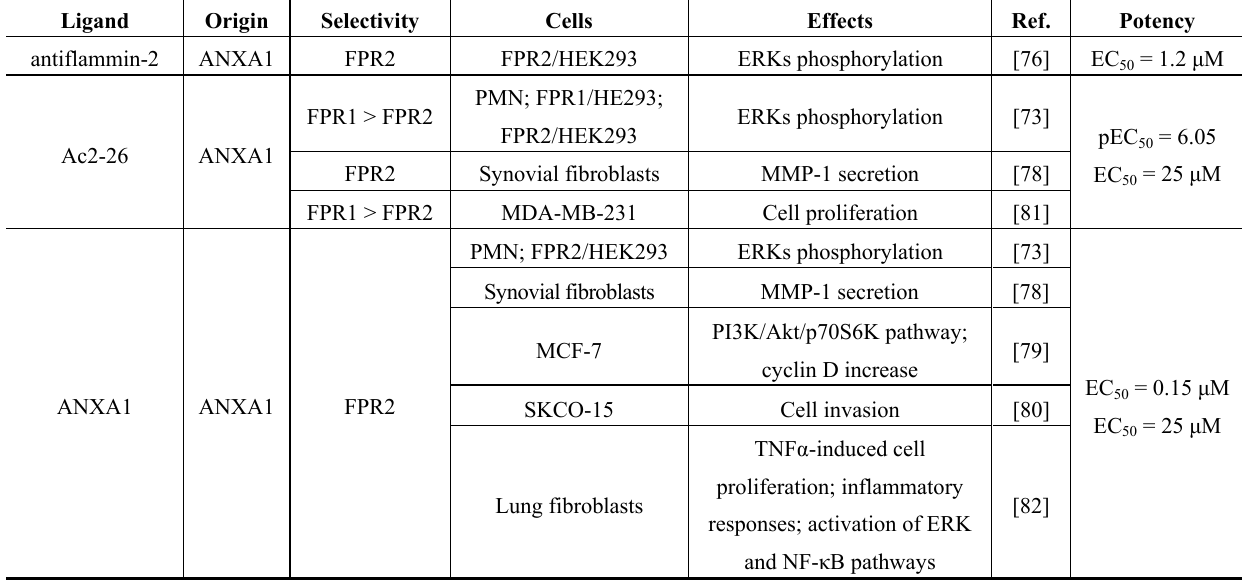
Table 5. Intracellular signaling cascades triggered by annexin A1 and derived